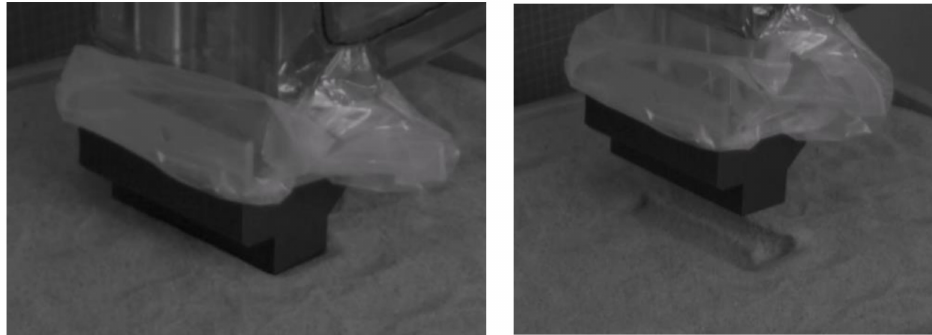
Figure 19. Jump in quartz sand with the foot in configuration #2.